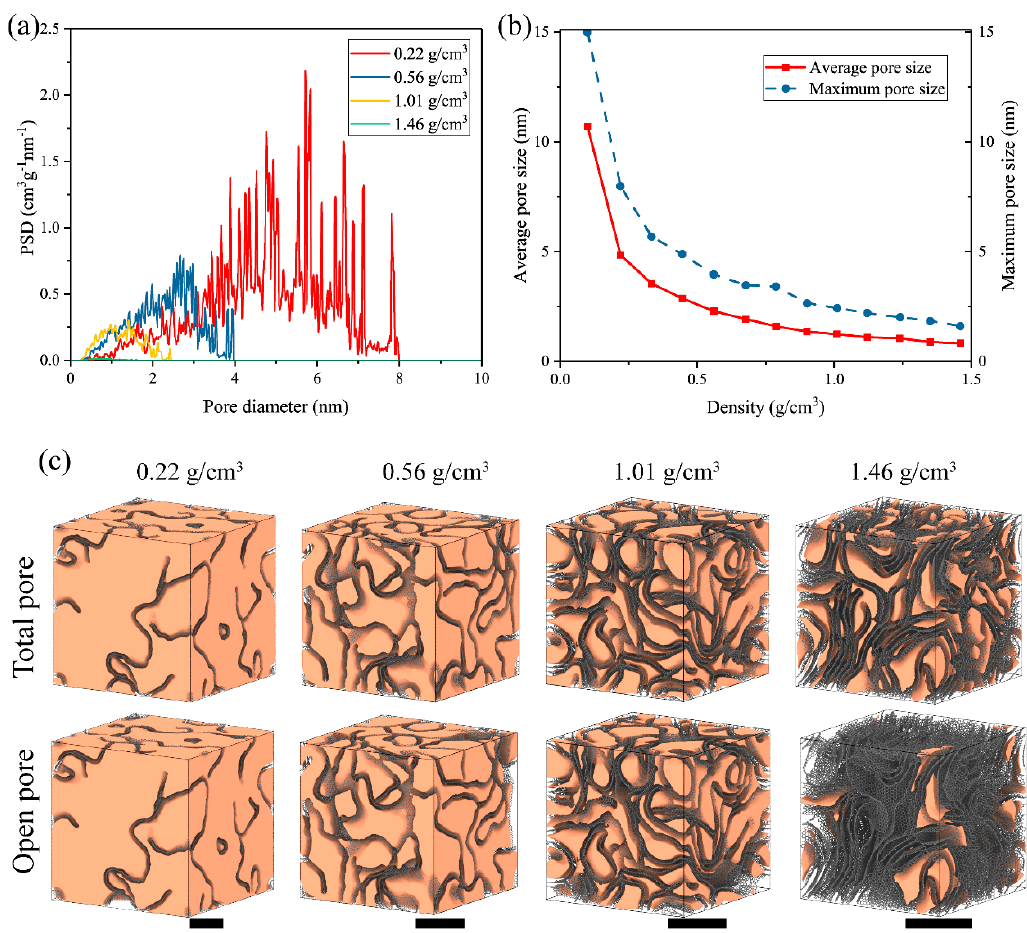
Figure 4. ( a ) Pore size distribution function at different densities. ( b ) Average pore size and maximum pore size obtained from the pore size distribution (PSD) as a function of density. ( c ) Rendered images of total and open pore structures for several densities. The black scale bars represent 5 nm.